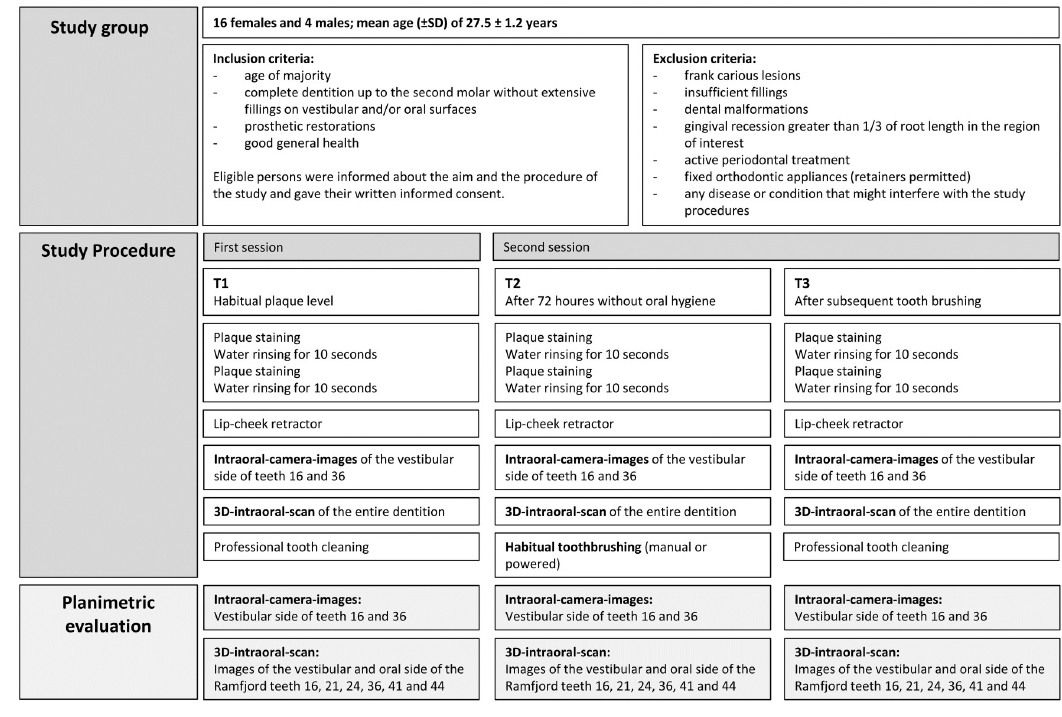
Fig 1. Flow chart of study